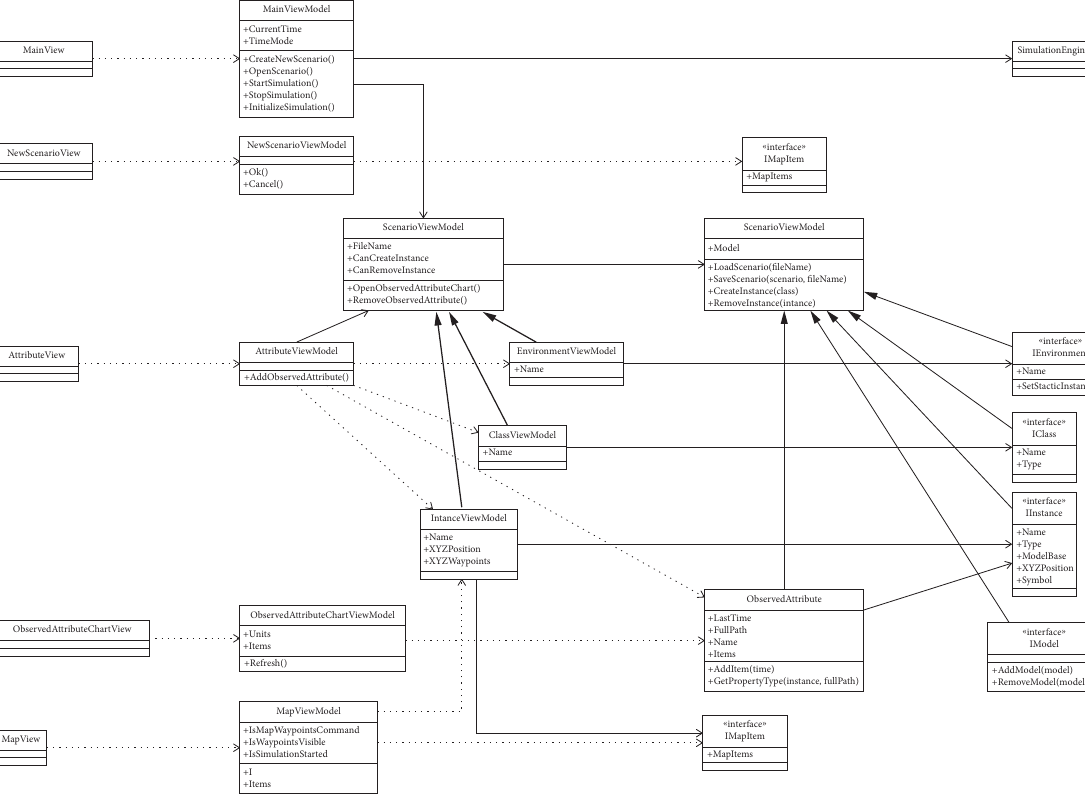
Figure 4: Simplified class diagram of the combat management